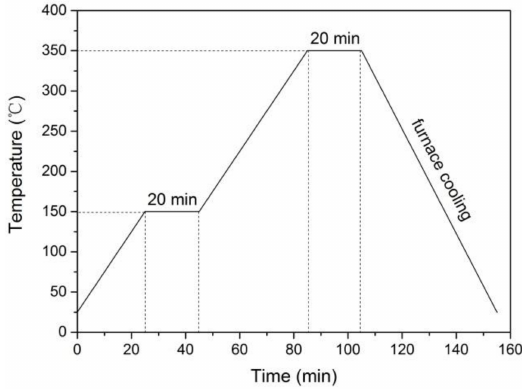
Figure 1. Sintering treatment